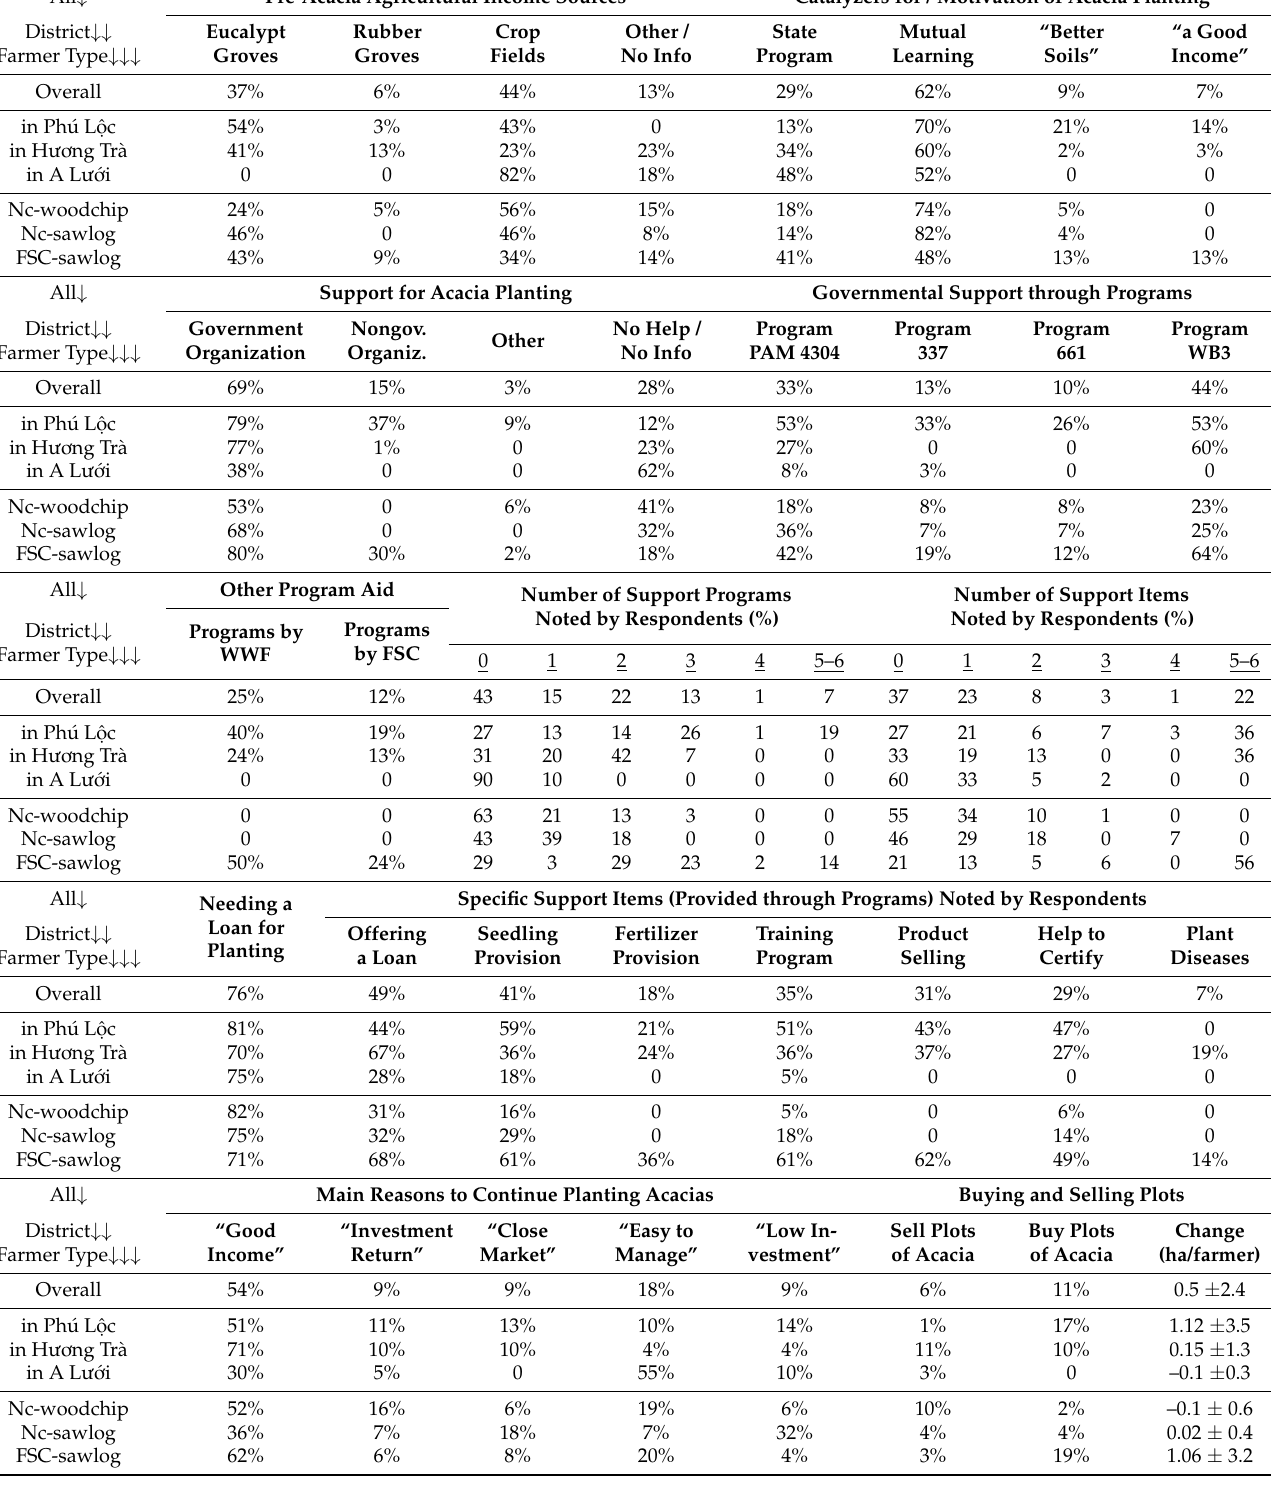
Table 2. Summary of data on the history and involvement in plantation forestry, showing differences among the three study districts (A L ướ i, H ươ ng Tr à and Ph ú L ộ c) and farmer types (Nc-woodchip, Nc-sawlog, and FSC-sawlog